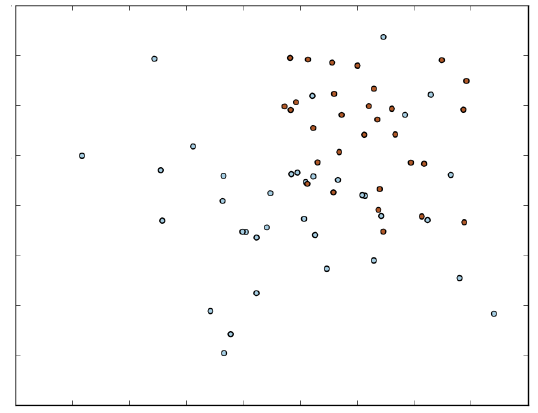
Figure 7. Example of two generated classes by the CIPBR algorithm.